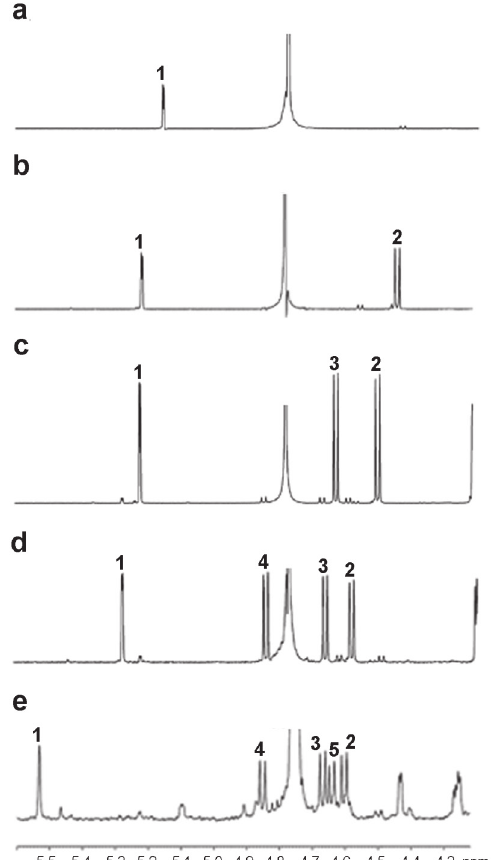
Figure 1 - 1 H NMR spectra of O -glycans released from mucins of T. cruzi strain Silvio X10/1. a - monosaccharide alditol; b - disaccharide alditol; c - trisaccharide alditol; d - tetrasaccharide alditol and e - pentasaccharide alditol. 1. Gal f -β-1-4-GlcNAc-ol; 2. Gal p -β-1-6-GlcNAc-ol; 3. Gal p -β-1-2-Gal p ; 4 Gal p - β-1-3-Gal p ; 5. Gal p -β-1-2-Gal f